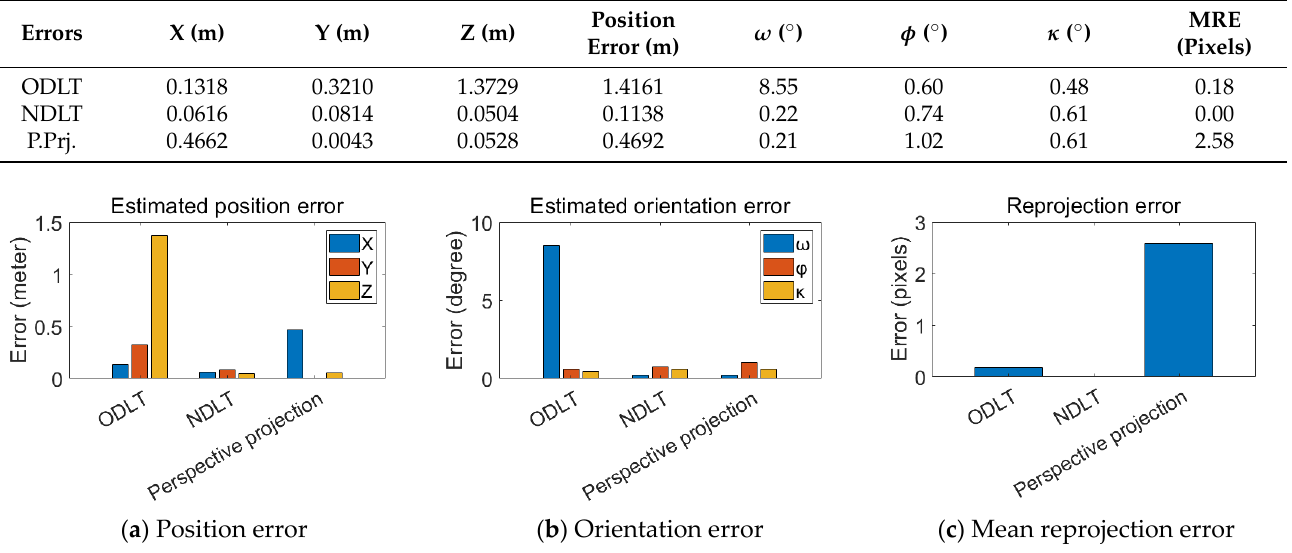
Table 9. Estimated EOP and reprojection errors of a smartphone.